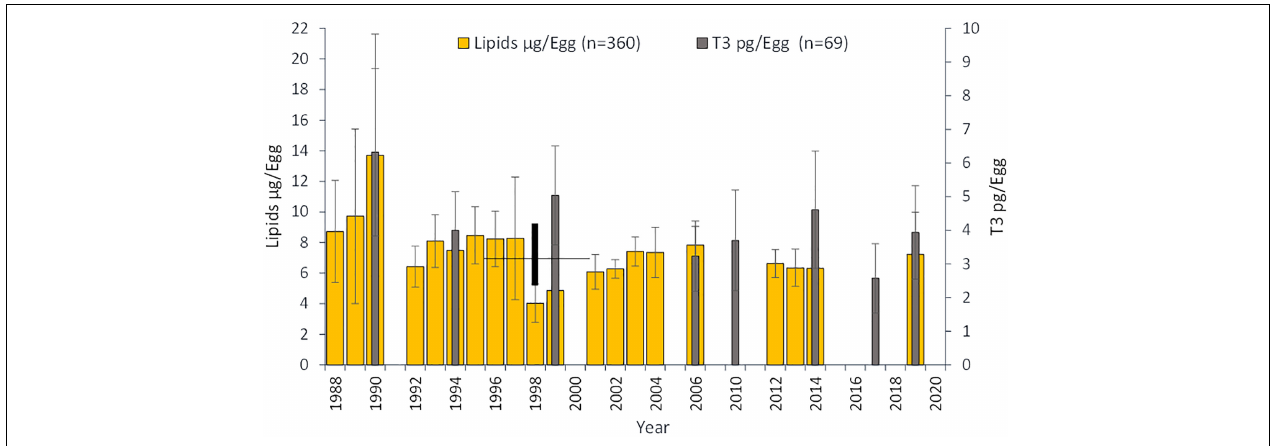
FIGURE 6 | The mean amount of lipids ( µ g) and triiodothyronine (T3 pg) per one egg ( ± SD) in the Baltic herring in the Archipelago Sea, northern Baltic in different years. Black vertical bar indicates the breakpoint year (1998) with standard error ( ± 3 years) in the timeseries of the egg lipid content; see text.